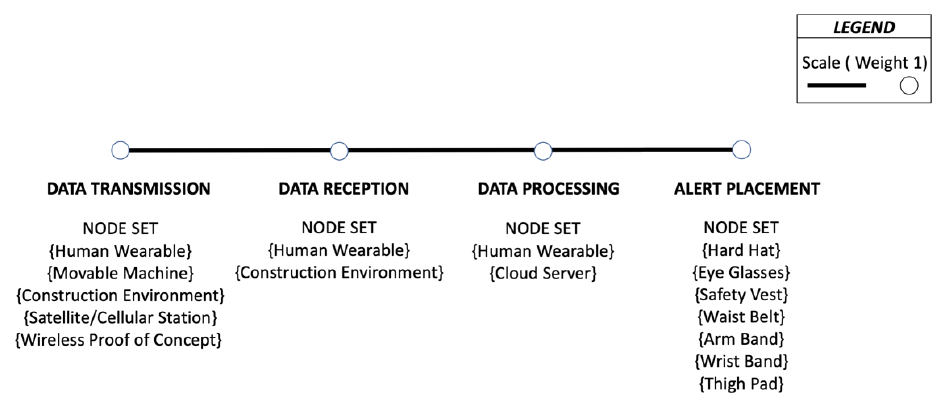
Figure 3. An account of the nodes involved in the novel wireless communication network concept.